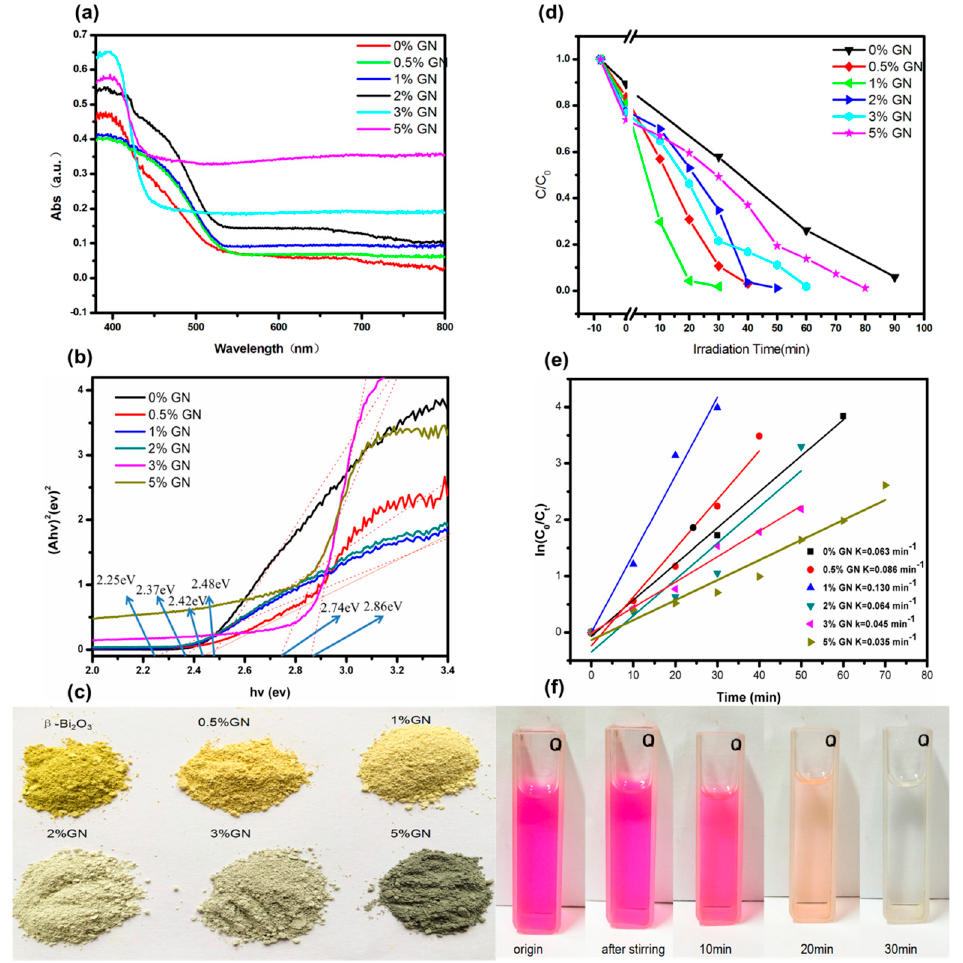
Figure 5. ( a ) The spectrogram of UV-VIS diffuse reflectance of GN with different mass ratios; and ( b ) corresponding band gap energy; ( c ) the chart of the corresponding sample color change; ( d ) the Rhodamine B (RhB) degradation rates of samples with different quantity ratios of GN; ( e ) kinetic curve of photodegradation; ( f ) color change chart of RhB solution by 1% GN degradation.